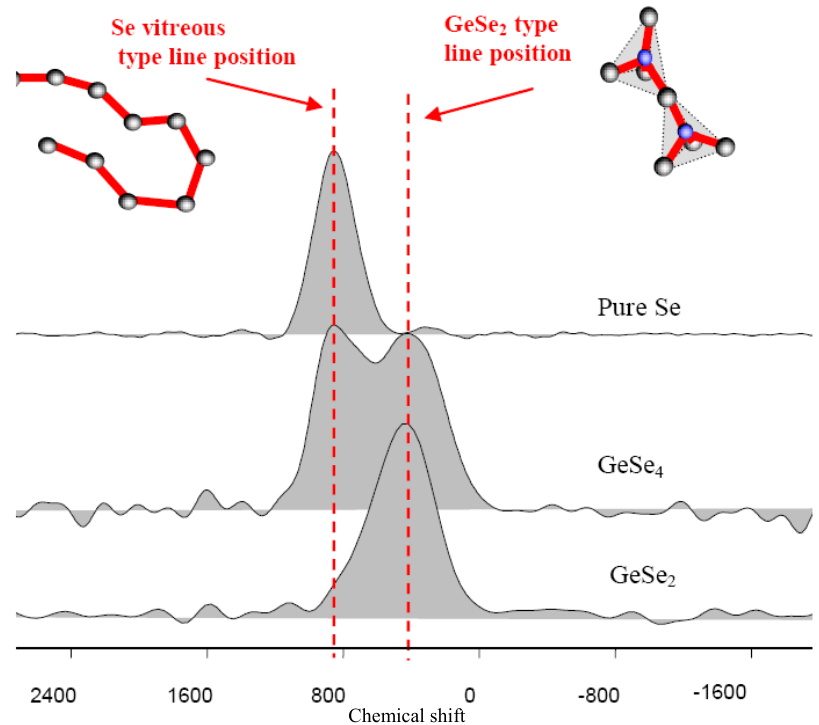
Figure 4. 77 Se solid state NMR spectra in the Ge/Se system, showing the presence of only two environments around the selenium : two selenium like in pure Se, and two germanium like in GeSe 2